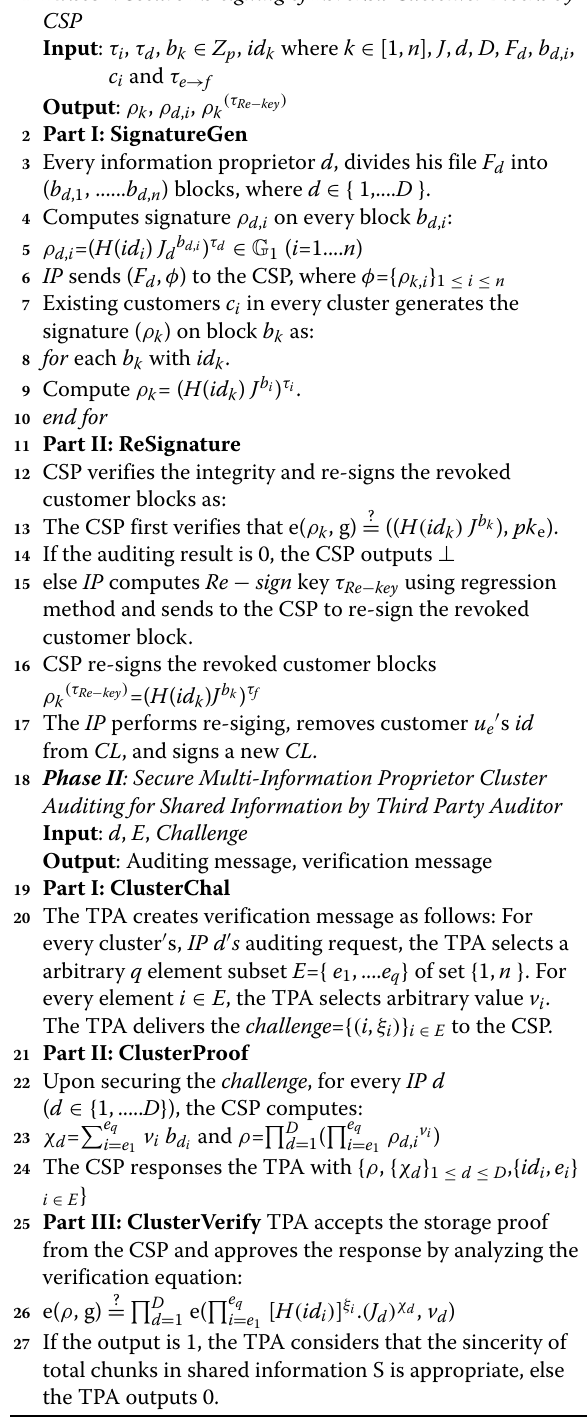
Algorithm 2: CRUPA: Collusion Resistant User Revocable Public Auditing of Shared Data in